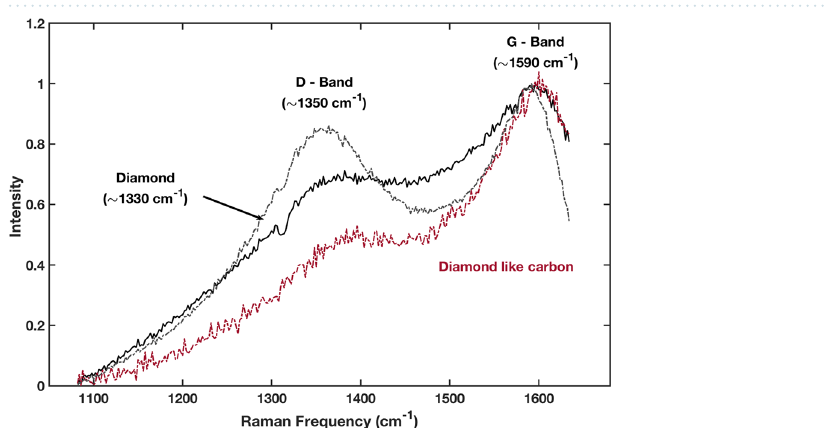
Figure 5. Calculated electron yield from graphite caused by the irradiation with the commercial L10366 Hamamatsu Deuterium lamp. The calculations have been made using the known yield from bulk graphite which is the least favourable case 20